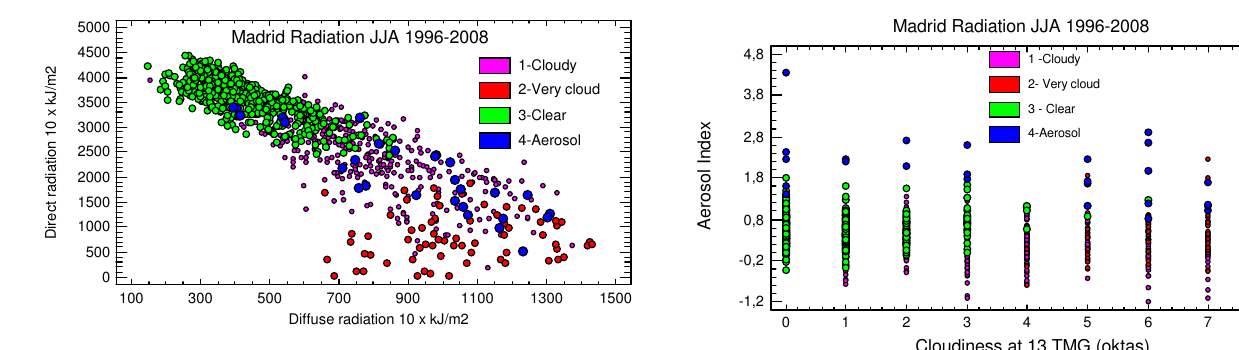
Figure 1. Scattergram direct versus diffuse solar radiation over Madrid in June-July-August Fig. 1. Scattergram direct versus diffuse solar radiation over Madrid for every day with satellite TOC and AI selected value from EP TOMS and OMI instruments in June-July-August for every day with satellite TOC and AI se- lected value from EP TOMS and OMI instruments in the period in the period 1996-2008. Four clusters classification based on global, direct, diffuse radiation 1996–2008. Four clusters classification based on global, direct, dif- values and cloudiness at 13 TMG over Madrid plus Aerosol Index from satellite overpasses fuse radiation values and cloudiness at 13 TMG over Madrid plus over Madrid. Aerosol Index from satellite overpasses over Madrid.